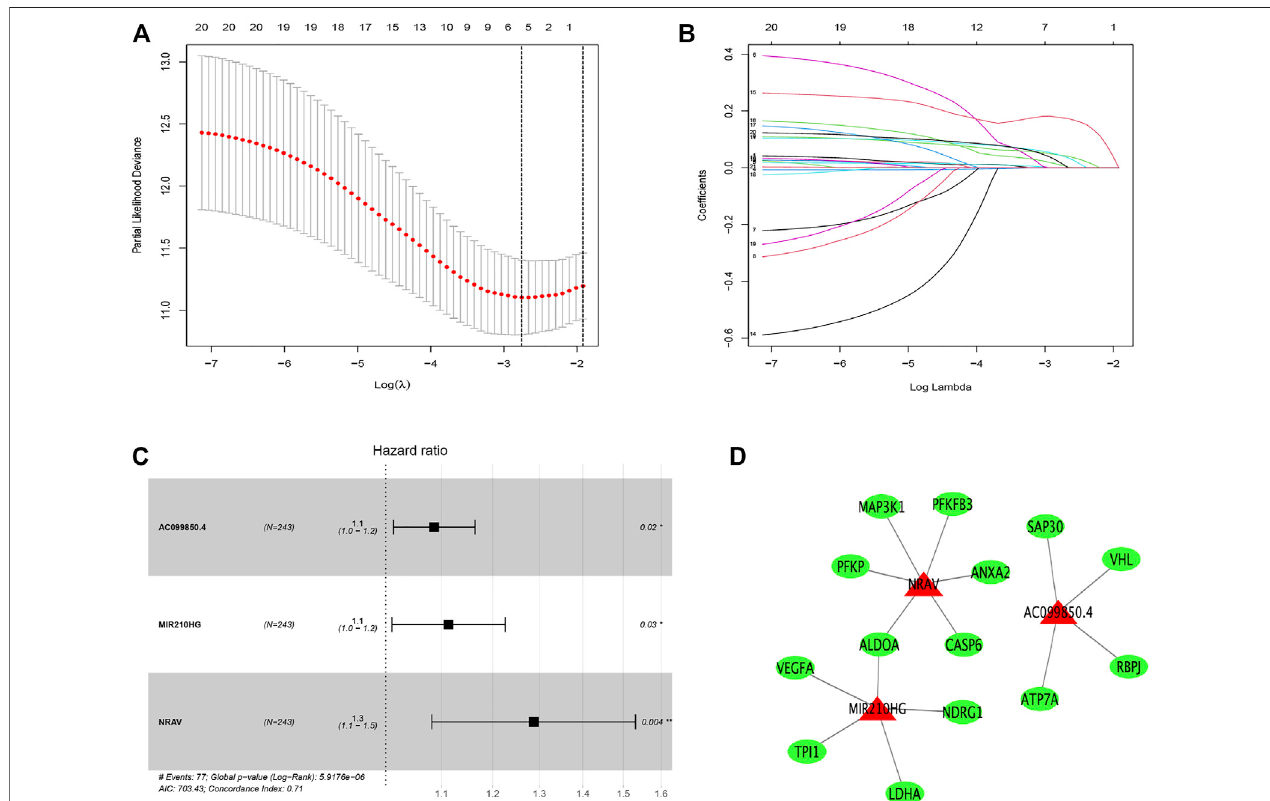
FIGURE 2 | Distinction of hypoxia-related lncRNAs signature: LASSO (A,B) and multivariate (C) Cox regression analysis. The relationship between the prognostic lncRNAs (red) and genes (green) (D) .